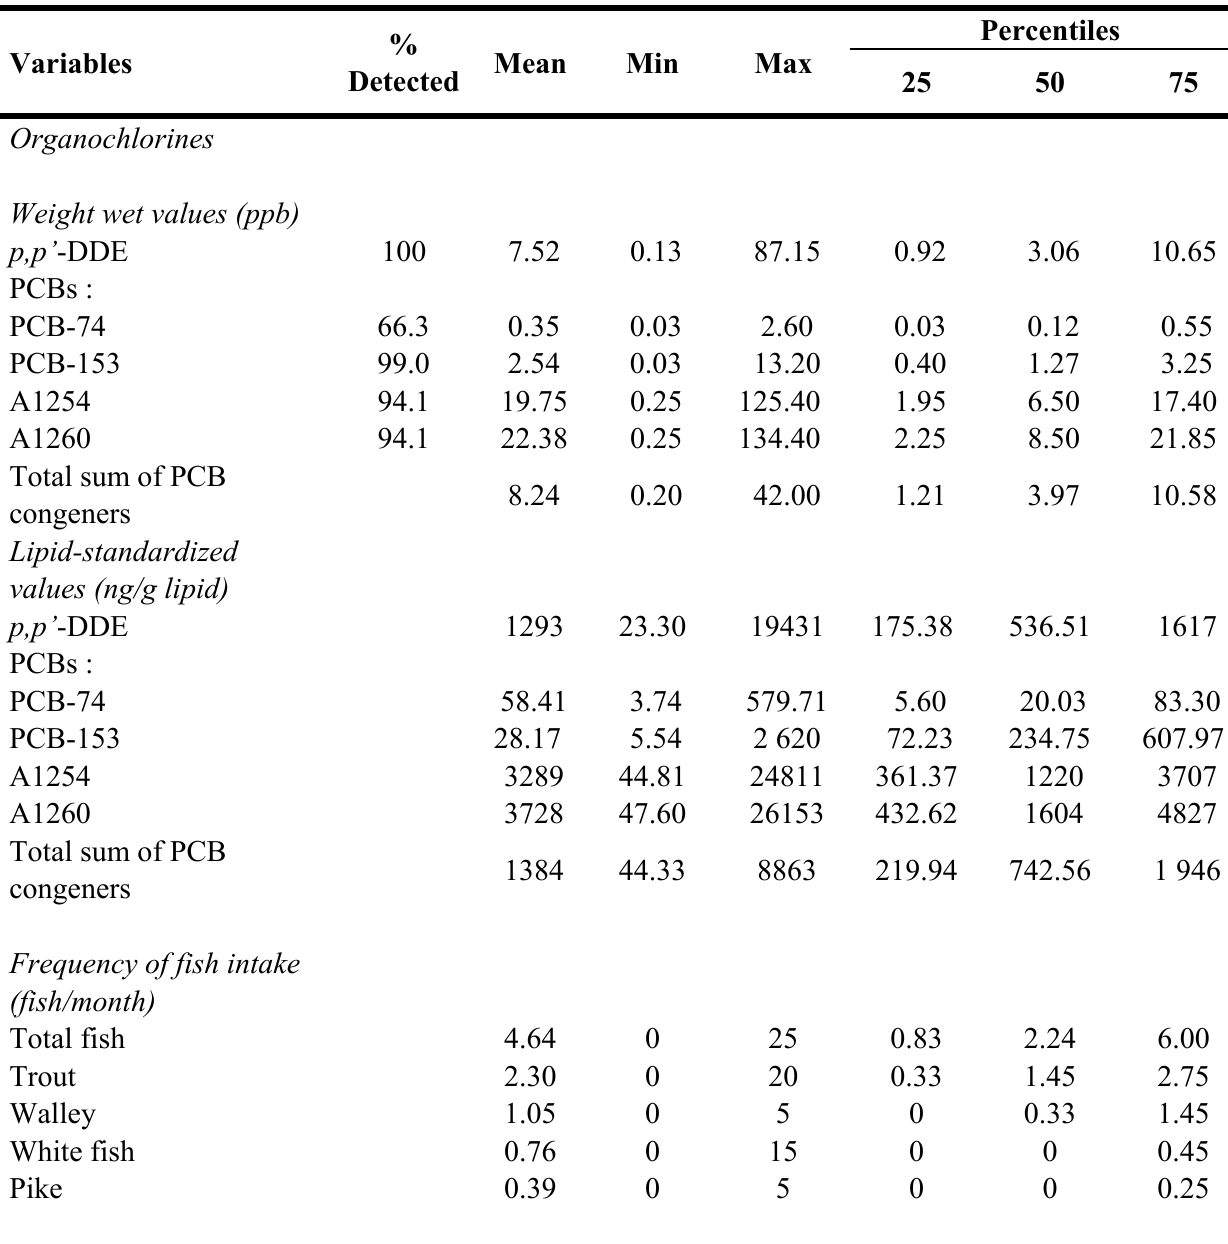
Table 1. Characteristics of mean (min-max) and percentiles of wet weight and lipid- standardized values of serum p,p’ -DDE and PCBs and frequency of fish